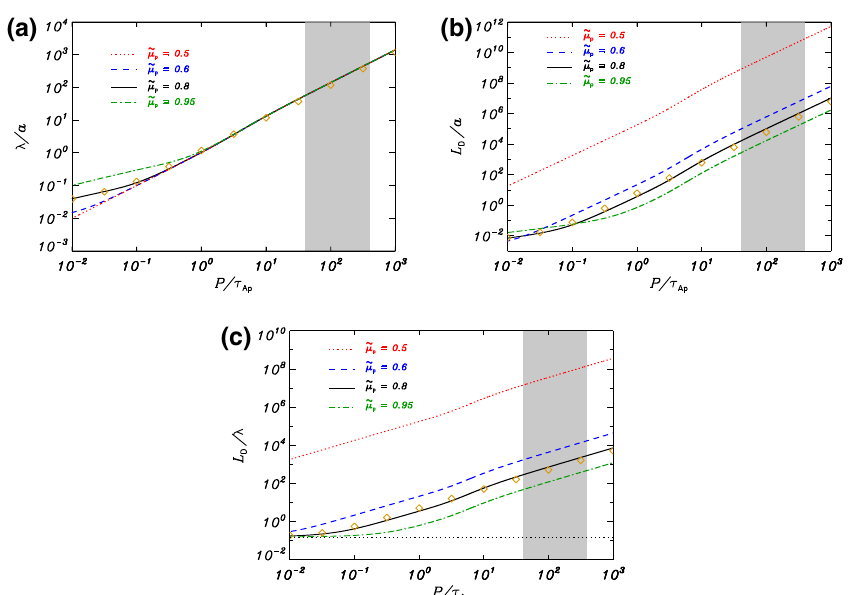
Fig. 76 Spatial damping of kink waves due to ion-neutral effects in an infinitely long prominence thread. Results for the kink mode spatial damping in the case l / a = 0: a λ/ a , b L D / a and c L D /λ versus P /τ Ap for ˜ μ p = 0 . 5, 0.6, 0.8 and 0.95. Symbols in ( a ), ( b ) and ( c ) correspond to the analytical solution given by Eqs. (12), (13) and (14) in Soler et al. (2011) in the thin tube approximation, while the horizontal dotted line in ( c ) corresponds to the limit of L D /λ for high frequencies. The shaded area denotes the range of observed periods of thread oscillations. Image reproduced with permission from Soler et al. (2011), copyright by